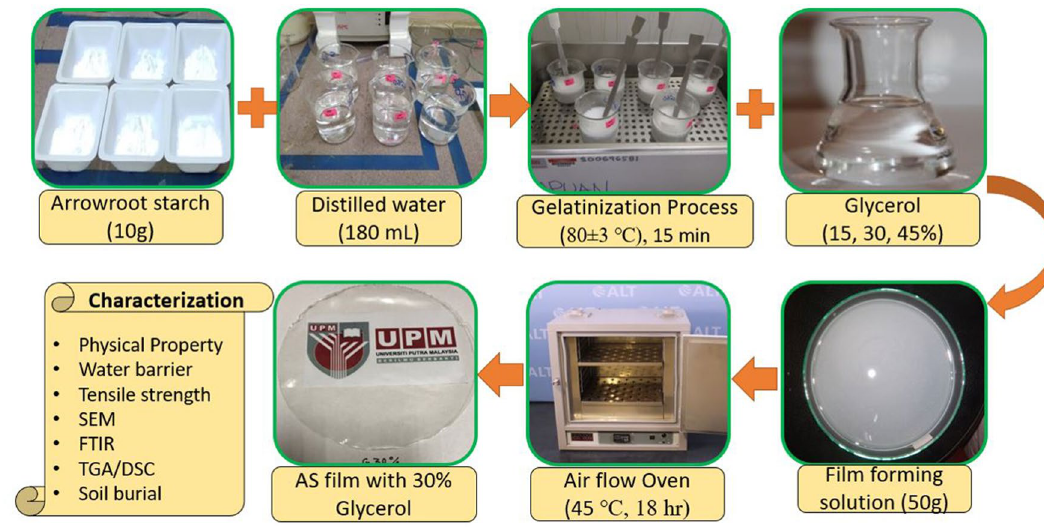
Figure 1. Flow diagram of film making process (Solution casting